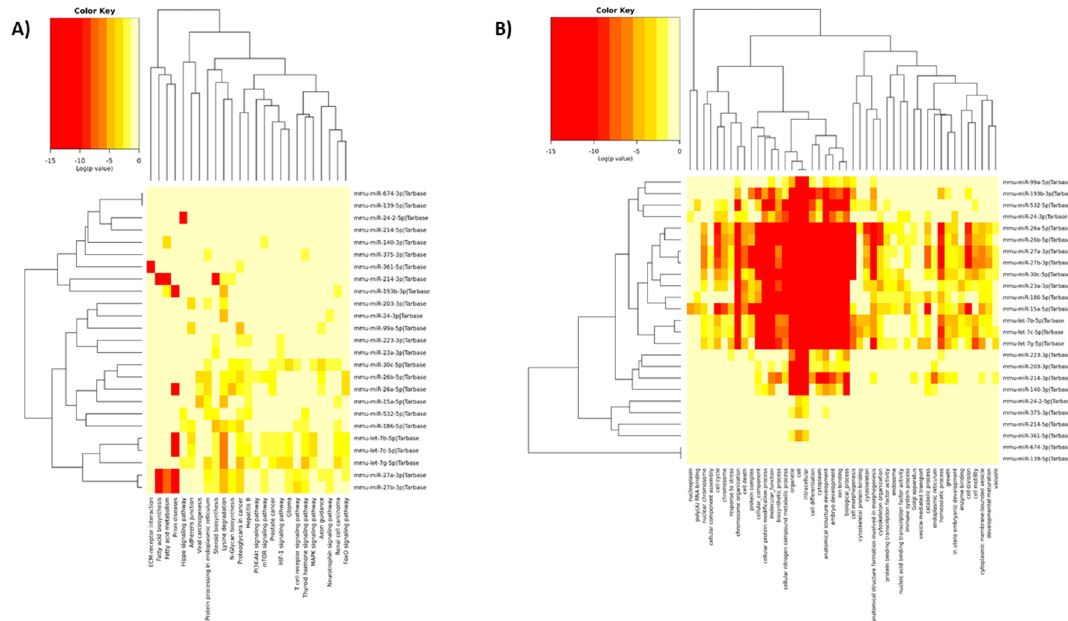
Figure 2. The relationship of miRNAs with Kyoto Encyclopedia of Genes and Genomes (KEGG) 1 pathways ( A ) or Gene Ontology (GO) annotations ( B ). The heatmaps present links of miRNAs (placed on the right side) with KEGG pathways or GO annotations (placed at the bottom of the heatmaps). The miRNAs clusters were marked on the left side of the heatmaps, while KEGG pathway or GO annotation clusters—at the top of the heatmaps. The significance of linking miRNAs to KEGG pathways or GO annotations is color-coded (the scale in the upper, left